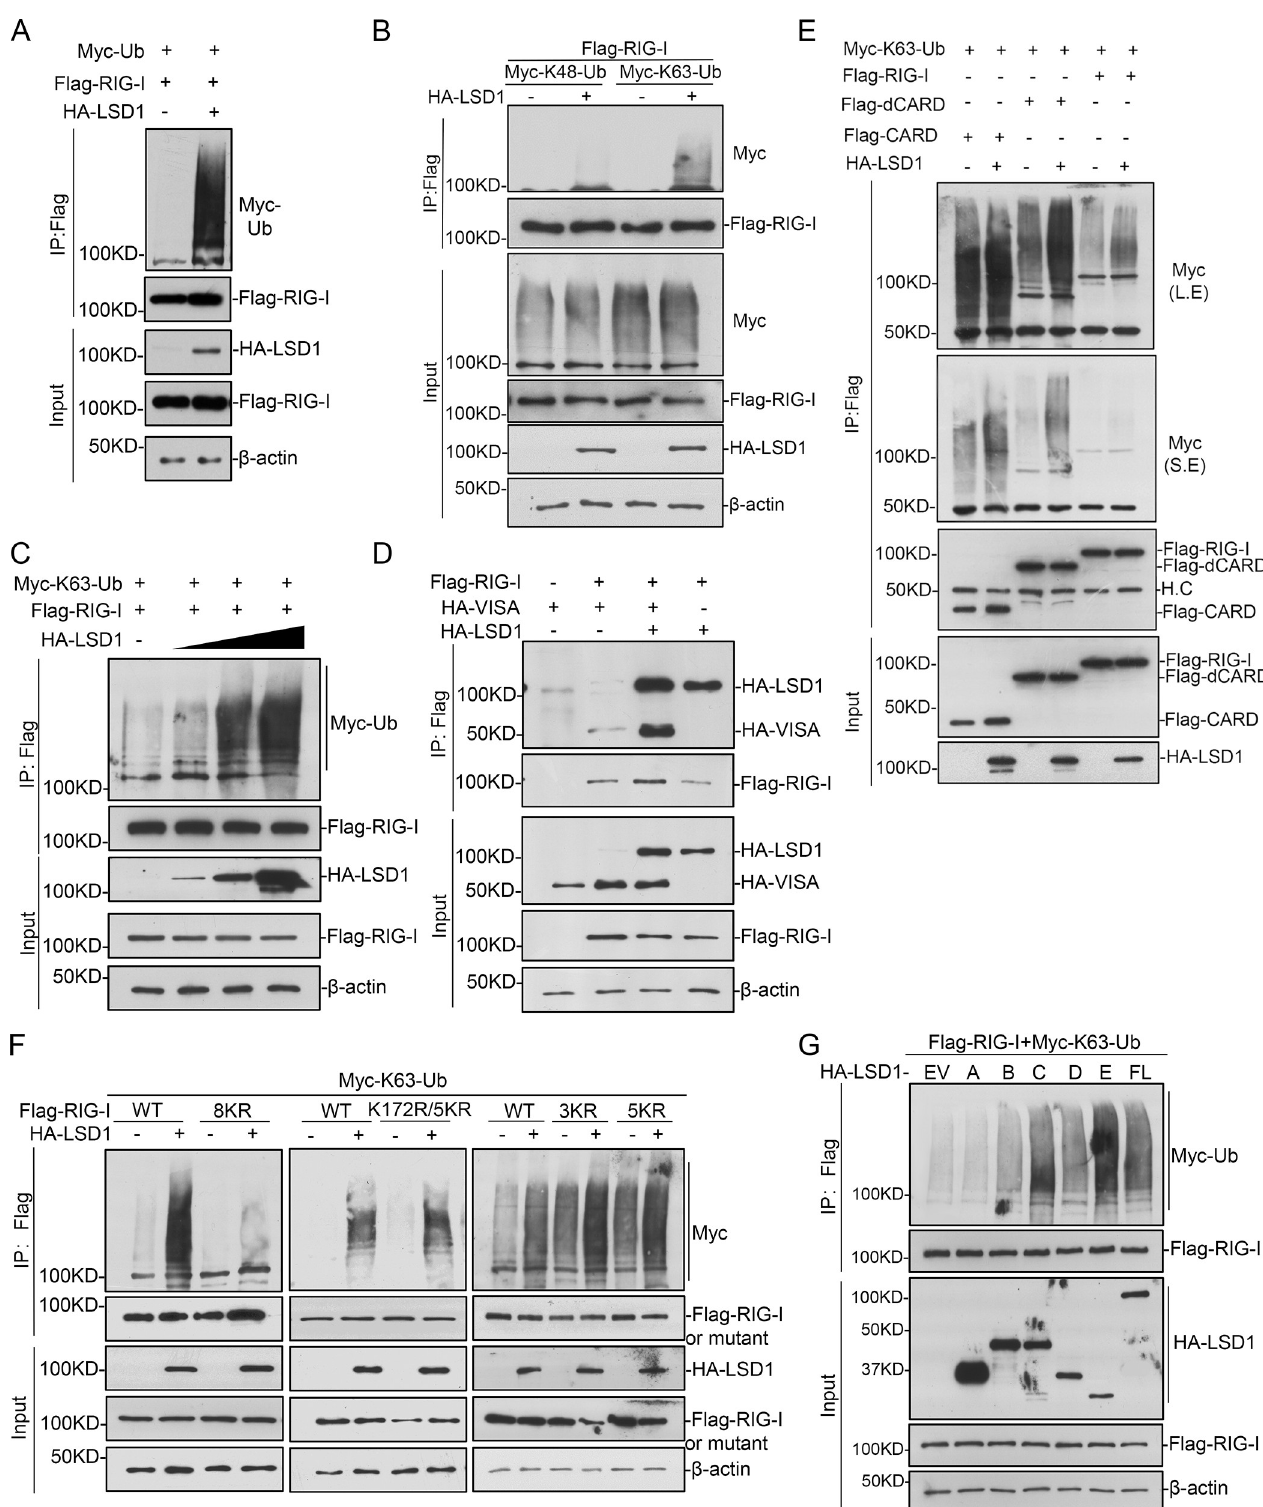
Fig 4. LSD1 enhances RIG-I K63-linked ubiquitination. (A) Flag-RIG-I and Myc-Ub together with control or HA-LSD1 were expressed in HEK293T for 24 hr, followed by immunoprecipitation and immunoblotting analysis as indicated. (B) The experiments were performed as in (A), except K48 only or K63 only ubiquitin plasmid was used instead of wild-type Ub. (C) HEK293T cells were transfected with Flag-RIG-I and Myc-K63-Ub together with a gradient dose of